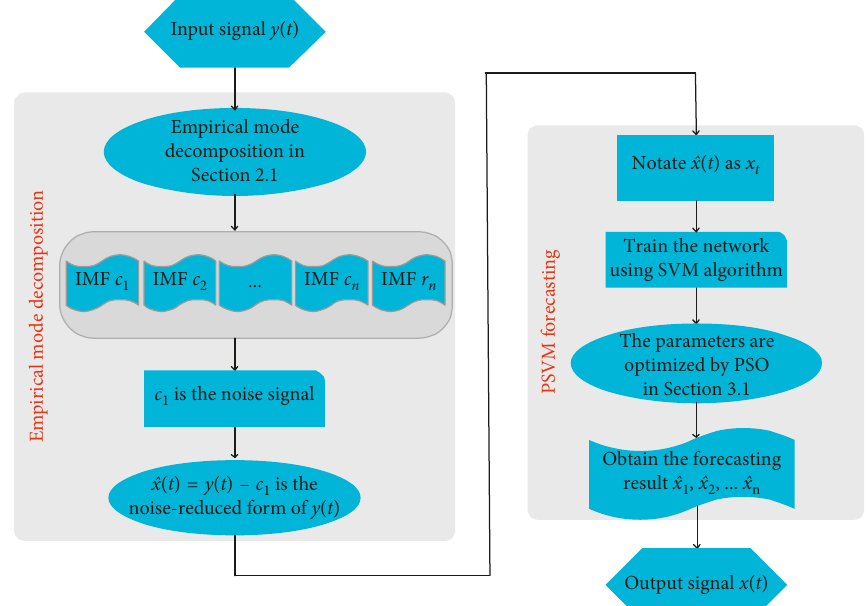
Figure 2: Flowchart of the proposed EPSVM